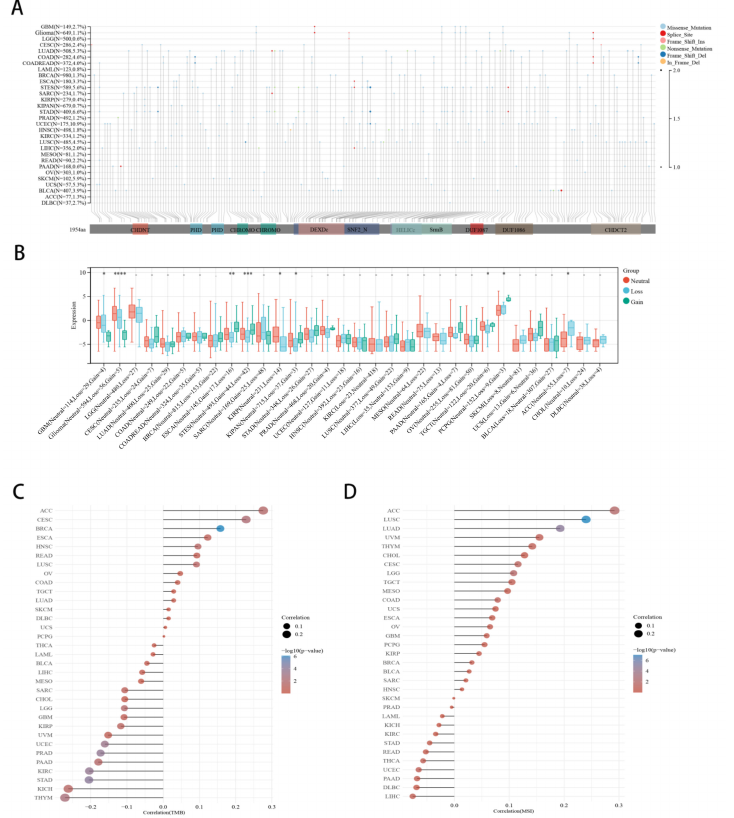
Figure 4. Correlation between CHD5 expression and CNV, TMB, and MSI in various cancer types. ( A ) Landscape of CHD5 mutation in 30 cancer types, ( B ) The CNV landscape of CHD5 mutations in 32 types of cancers, ( C , D ) Spearman correlation analysis for TMB, MSI and CHD5 gene expression. In the figure, the horizontal axis represents the correlation coefficient between the genes and TMB, and the vertical axis represents the different tumors. The size of the dots in the figure represents the correlation coefficient, and the different colors represent the significance of the p value. The bluer the color in the diagram, the smaller the p value. * p < 0.05, ** p < 0.01, *** p < 0.001, **** p <